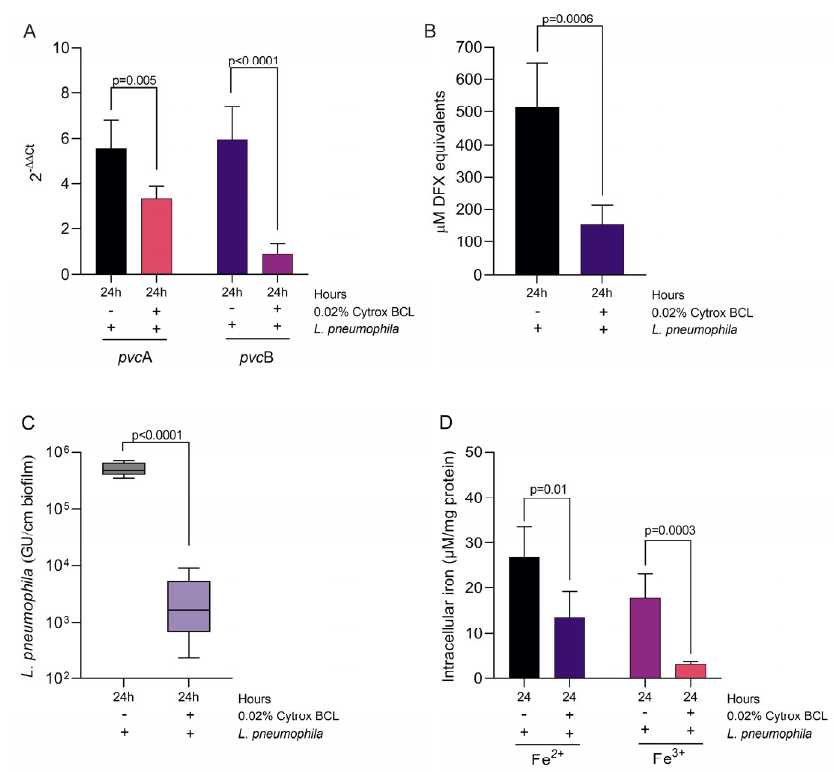
Figure 5. Expression of pvc A and pvc B genes (Panel ( A )), CAS reactivity in supernatants (Panel ( B )), number of L. pneumophila cells in formed biofilm (Panel ( C )) and the levels of iron in formed biofilms (Panel ( D )). The results are presented as means and standard deviations from triplicate samples and from three separate experiments. The supernatant’s CAS reactivity was tested in triplicates from three separate experiments ( p < 0.05; Student’s t ‐ test).